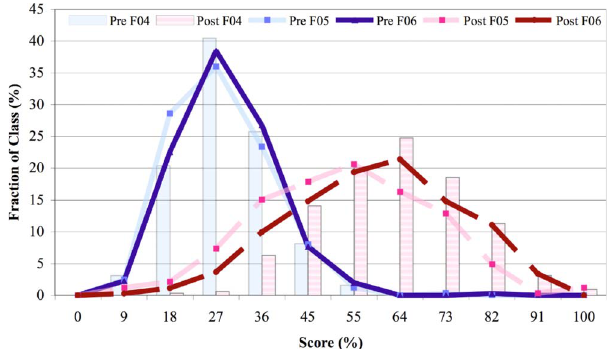
FIG. 4. (cid:1) Color (cid:2) Pre- (cid:1) on the left (cid:2) and post- (cid:1) right (cid:2) BEMA scores for second semester into physics. The bars (cid:1) shown lightly, in back- ground (cid:2) are coarsely binned data taken from Fig. 2, representing student performance in classes taught by PER faculty. The line plots are predata (cid:1) solid (cid:2) and postdata (cid:1) dashed (cid:2) for instructor I4 during two different implementations. The lighter lines are the first imple- mentation: the darker lines are his second time teaching